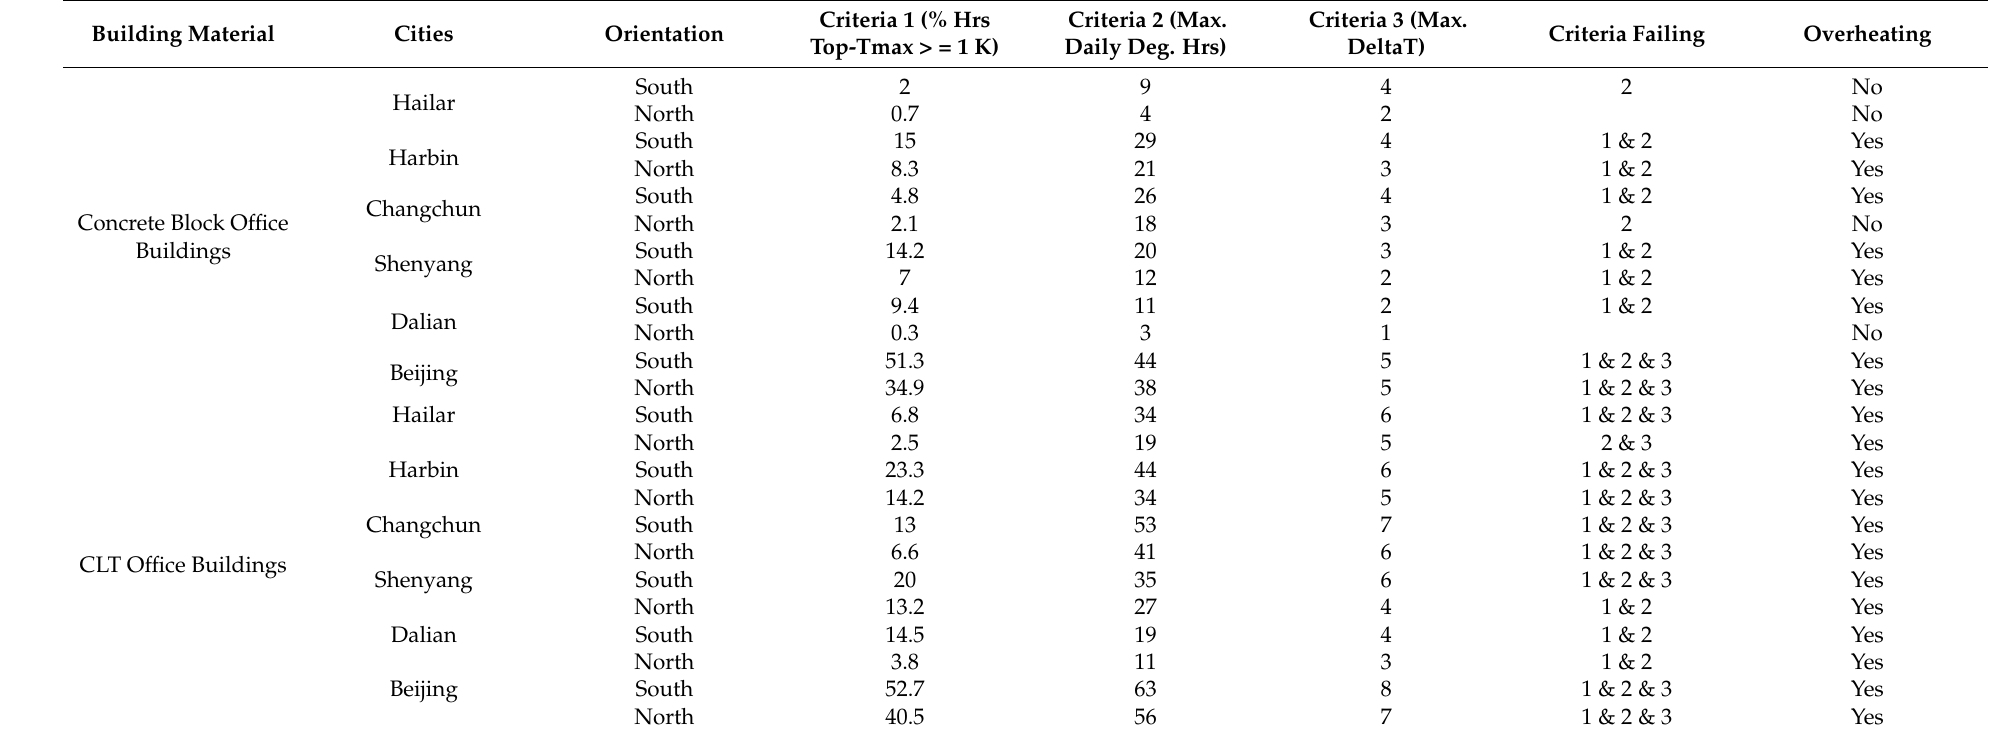
Table 12. Assessment of overheating in concrete block and CLT buildings (7th floor S6) based on CIBSE TM